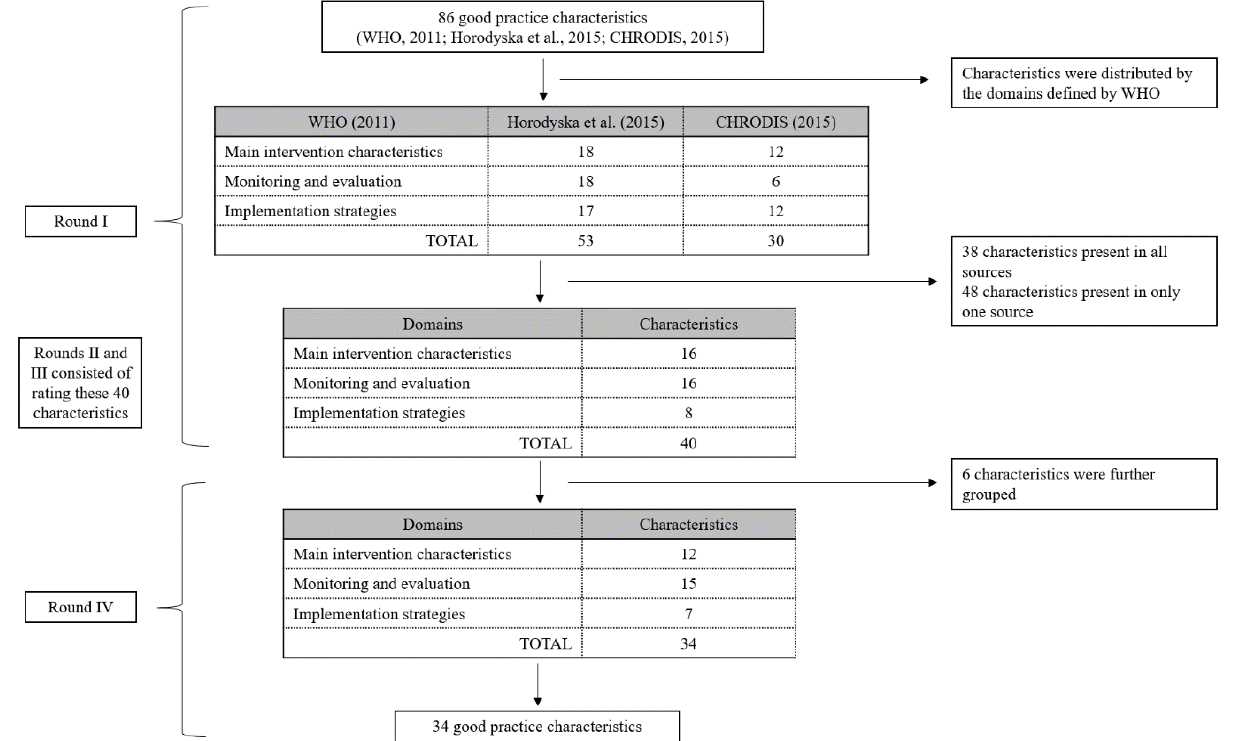
Figure 1. Process of developing the tool for evaluating good practice characteristics in PACIs.